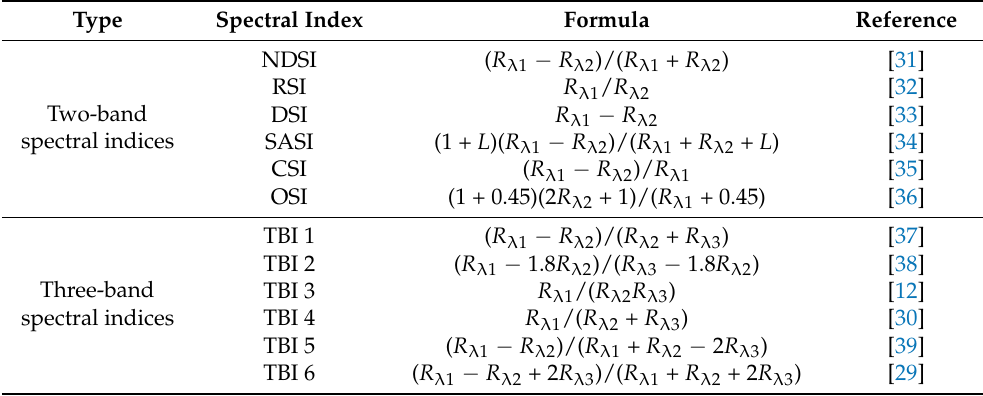
Table 1. Formulas for selected two- and three-band spectral indices used in this